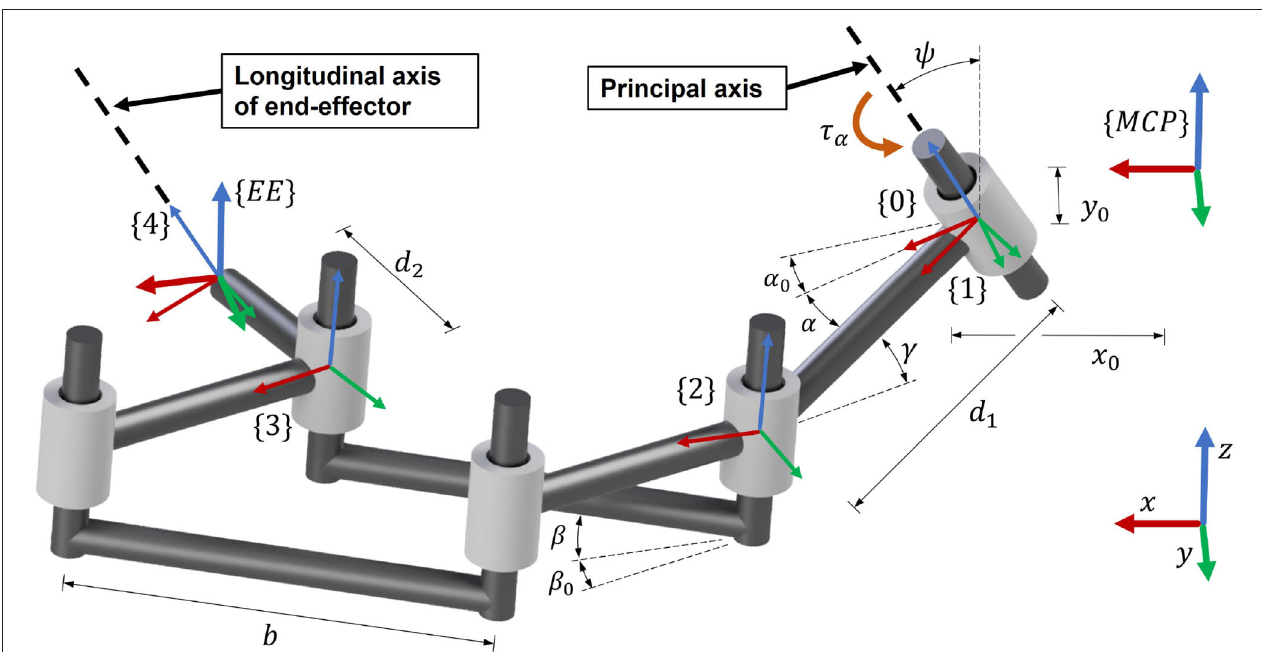
FIGURE 6 | Schematic representation of the kinematics of the device.